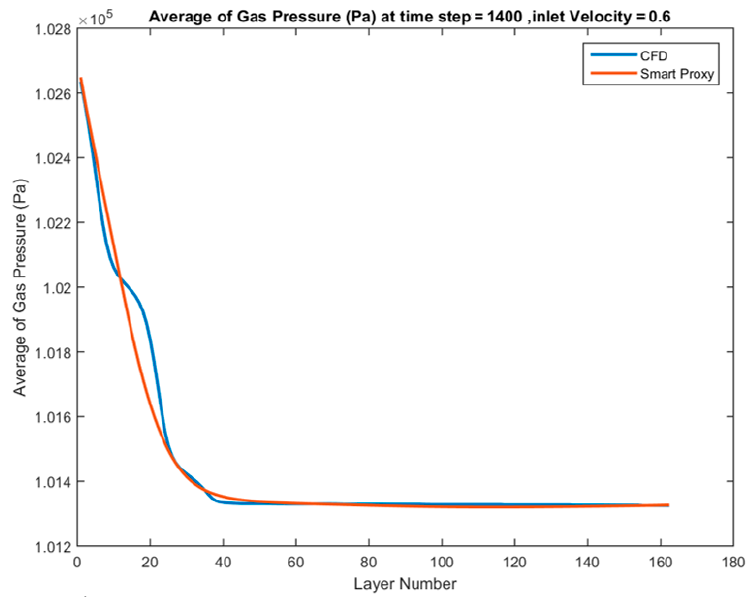
Figure 40. Spatially averaged CFD and smart proxy results for gas pressure (Pa) at time step = 1400 and V in = 0.6 m/s.